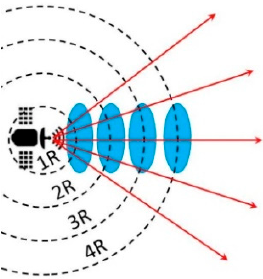
Figure 2. The signal energy decreases with distance from the satellite.